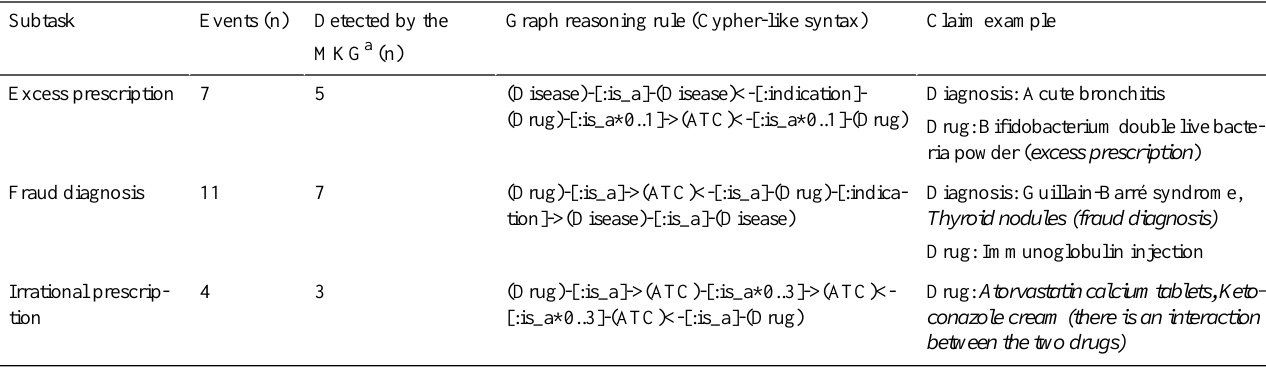
Table 9. Performance of claim